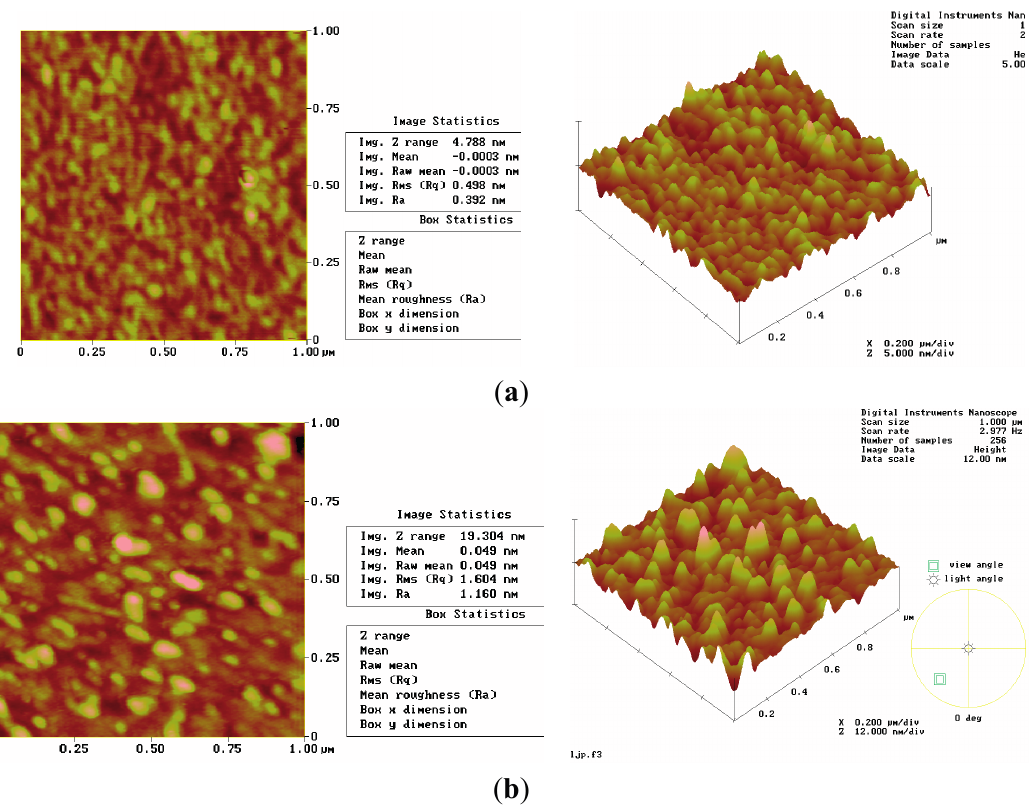
Figure 3. Atomic force microscope (AFM) two-dimensional and three-dimensional photographs of the surface acoustic wave (SAW) Au surface. ( a ) Bare Au film; ( b ) After the self-assembly